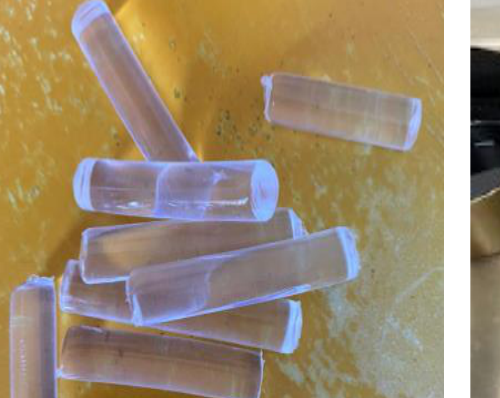
Figure 11. Cutting the polymers to small pieces Figure 12. Heating the polymers with the